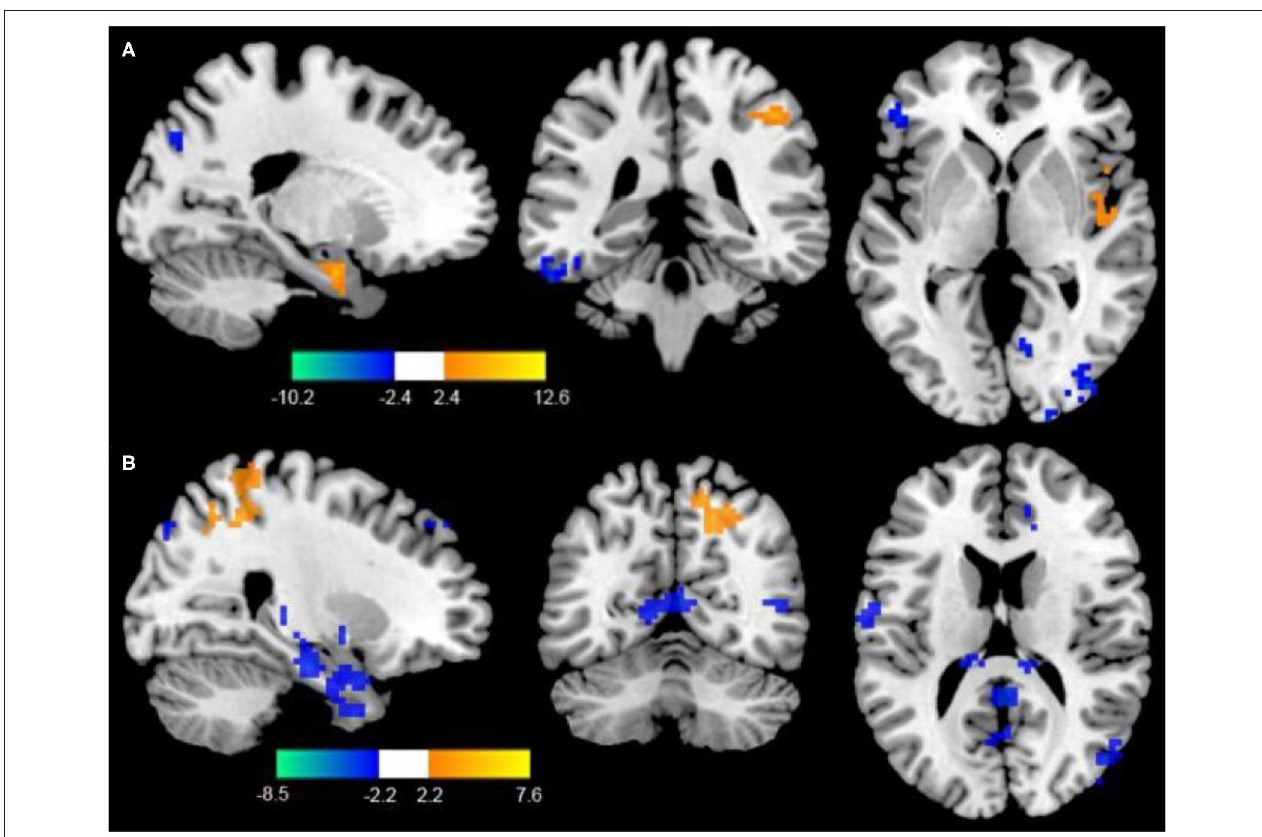
FIGURE 1 | (A) Differences of fALFF between the rTMS treatment group and the control group (two-sample t -test, P < 0.05, AlphaSim correction, cluster size ≥ 82 voxels). The yellow areas represent the regions which have increased fALFF, while the blue ones represent the regions which have decreased fALFF. (B) Differences of FC with the LDPFC between the rTMS treatment group and the control group (two-sample t -test, P < 0.05, AlphaSim correction, cluster size ≥ 85 voxels). The yellow areas represent the regions which have increased FC with the LDPFC, while the blue ones represent the regions which have decreased FC with the